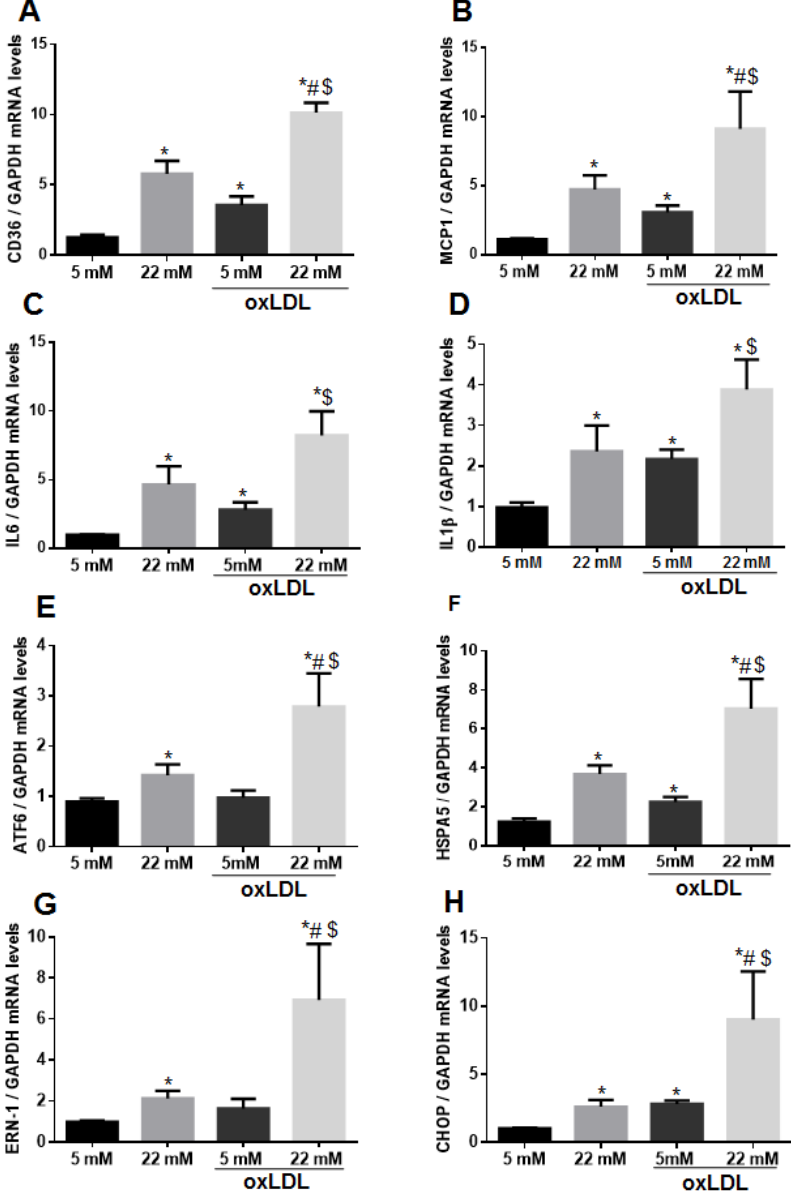
Figure 1. High glucose and oxidized low-density lipoprotein (oxLDL) synergize in increasing CD36 expression in vascular smooth muscle cells (VSMC). Starved VSMC were cultured for 72 h with M199 medium containing 5 mM (normal glucose, NG) or 22 mM of glucose (high glucose, HG) and treated or not with 50 μg/mL oxLDL for the last 24 h. ( A – H ) CD36, MCP1, IL6, IL-1β, and endoplasmic reticulum (ER) stress markers (ATF6, HSPA5, ERN-1 and CHOP) mRNA levels were determined by quantitative real-time PCR analysis (qPCR) and normalized to GAPDH. VSMC from at least four different donors were used. Mean fold change relative to untreated VSMC-NG ± SEM from five independent experiments performed in duplicate are shown. * p ≤ 0.05 vs. 5 mM; # p ≤ 0.05 vs. 22 mM; $ p ≤ 0.05 vs. 5 mM + oxLDL.